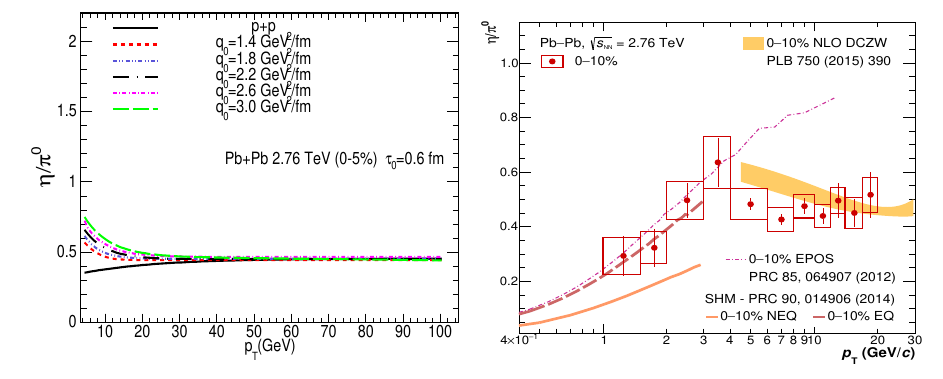
Figure 2. Left: theoretical prediction from our model on the η/π 0 ratio at NLO in central Pb + Pb collisions at the LHC [12]. Right: ALICE measurement of η/π 0 ratio in the centrality class 0 (circles) [24] including a comparison with our model calculations (solid band); figure from ALICE [24].